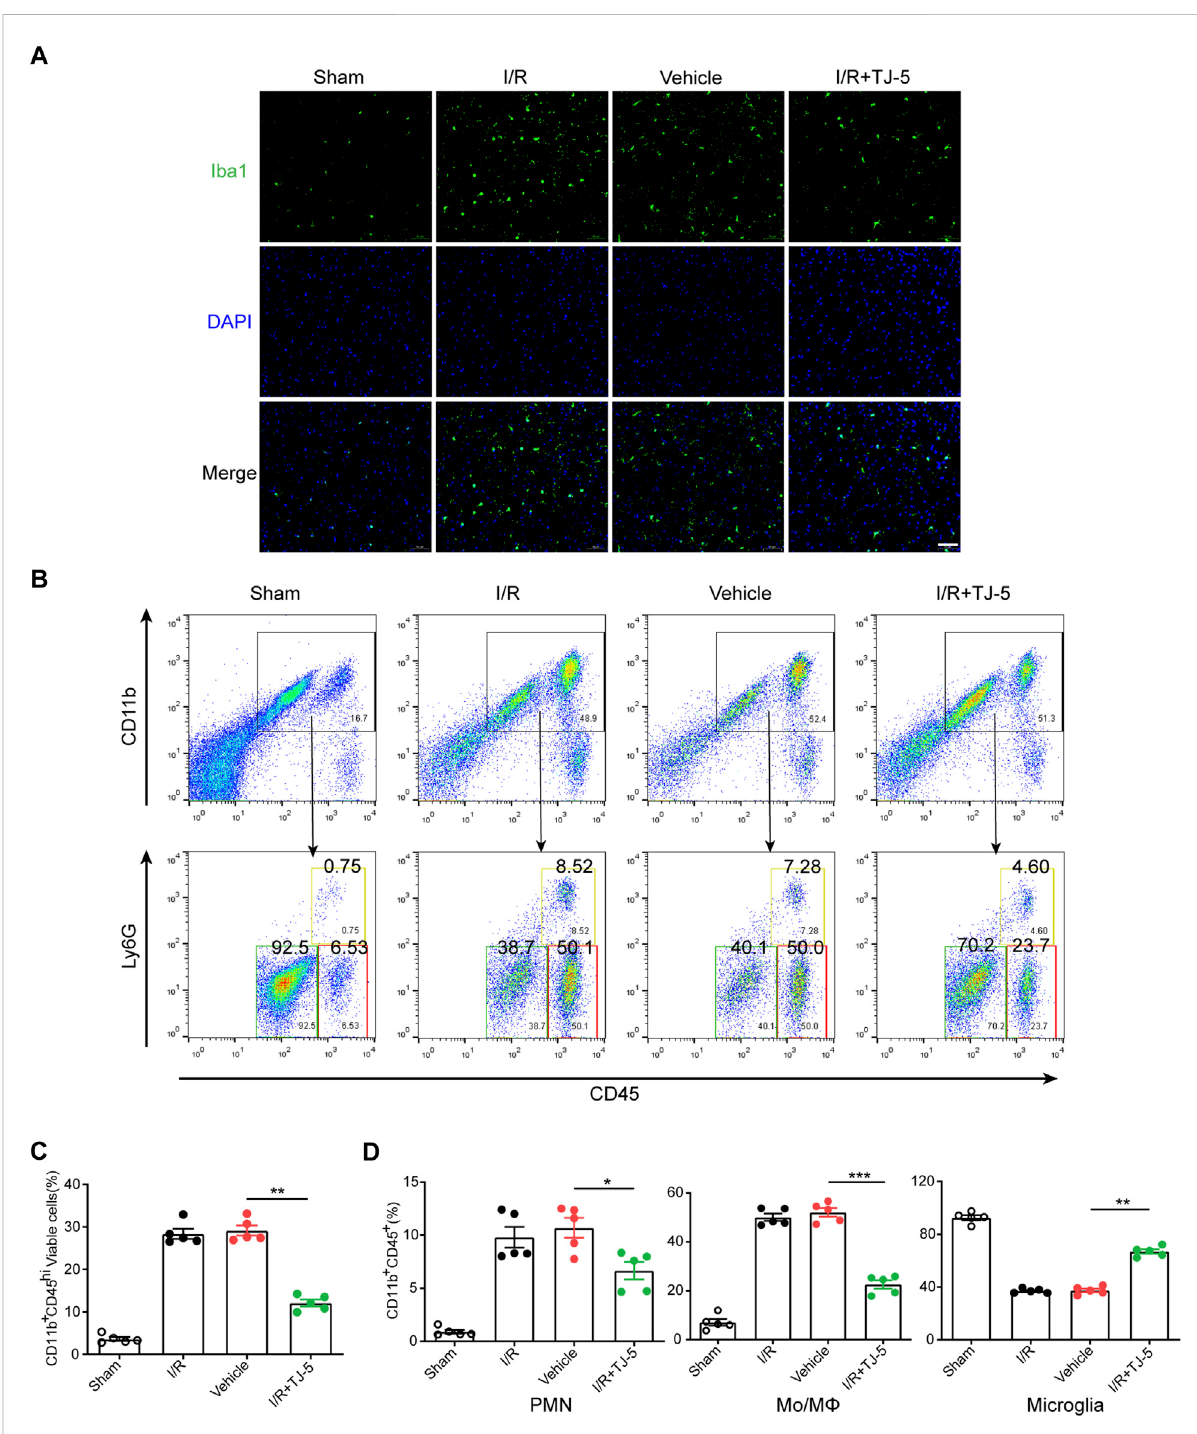
FIGURE 3 Effect of TJ-5 treatment on microglia and peripheral in fi ltrating myeloid cells in CIRI mice. Mice were injected intravenously with TJ-5 (15 mg/kg) after 1 h ischemia. (A) Representative Iba-1 staining image of the cortex (scale bar = 50 μ m); the activated microglia were decreased with TJ-5 treatment. (B) Immune cells were isolated from theischemic brain hemisphere after 24 h reperfusion and were stained with CD45, CD11b, and Ly6G. Plotsidentify CD11b + CD45 hi Ly6G − Mo/M Φ ,CD11b + CD45 int microgliaandCD11b + CD45 hi Ly6G + PMNs. (C) Percentage ofbrain-in fi ltrating CD11b + CD45 hi myeloid cells was statistically analyzed. (D) Percentages of PMNs, Mo/M Φ , and microglia in CD11b + CD45 + cells were statistically analyzed. All the experiments were repeated three times. Values are mean ± SEM. (* p < 0.05, ** p < 0.01, *** p <